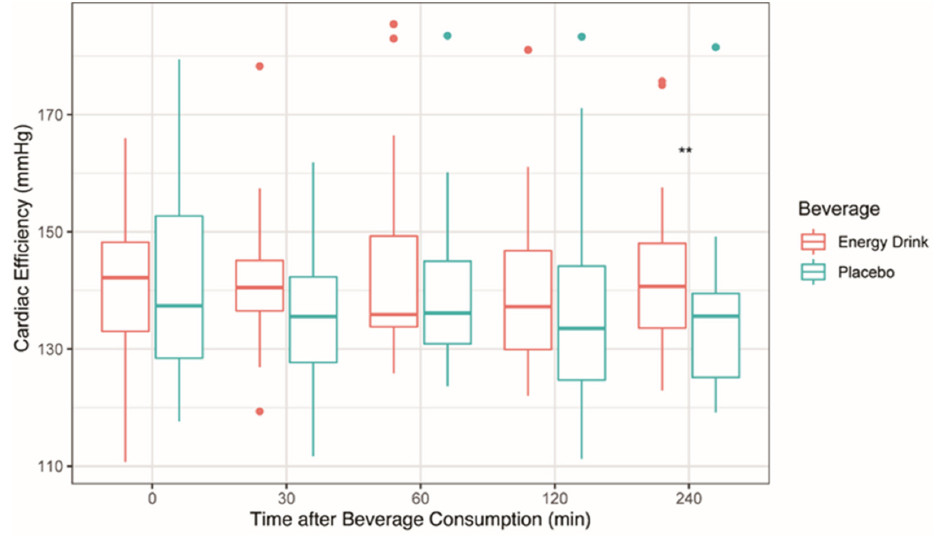
Figure 4. Acute Effects of Energy Drinks on Cardiac Efficiency. ** p <